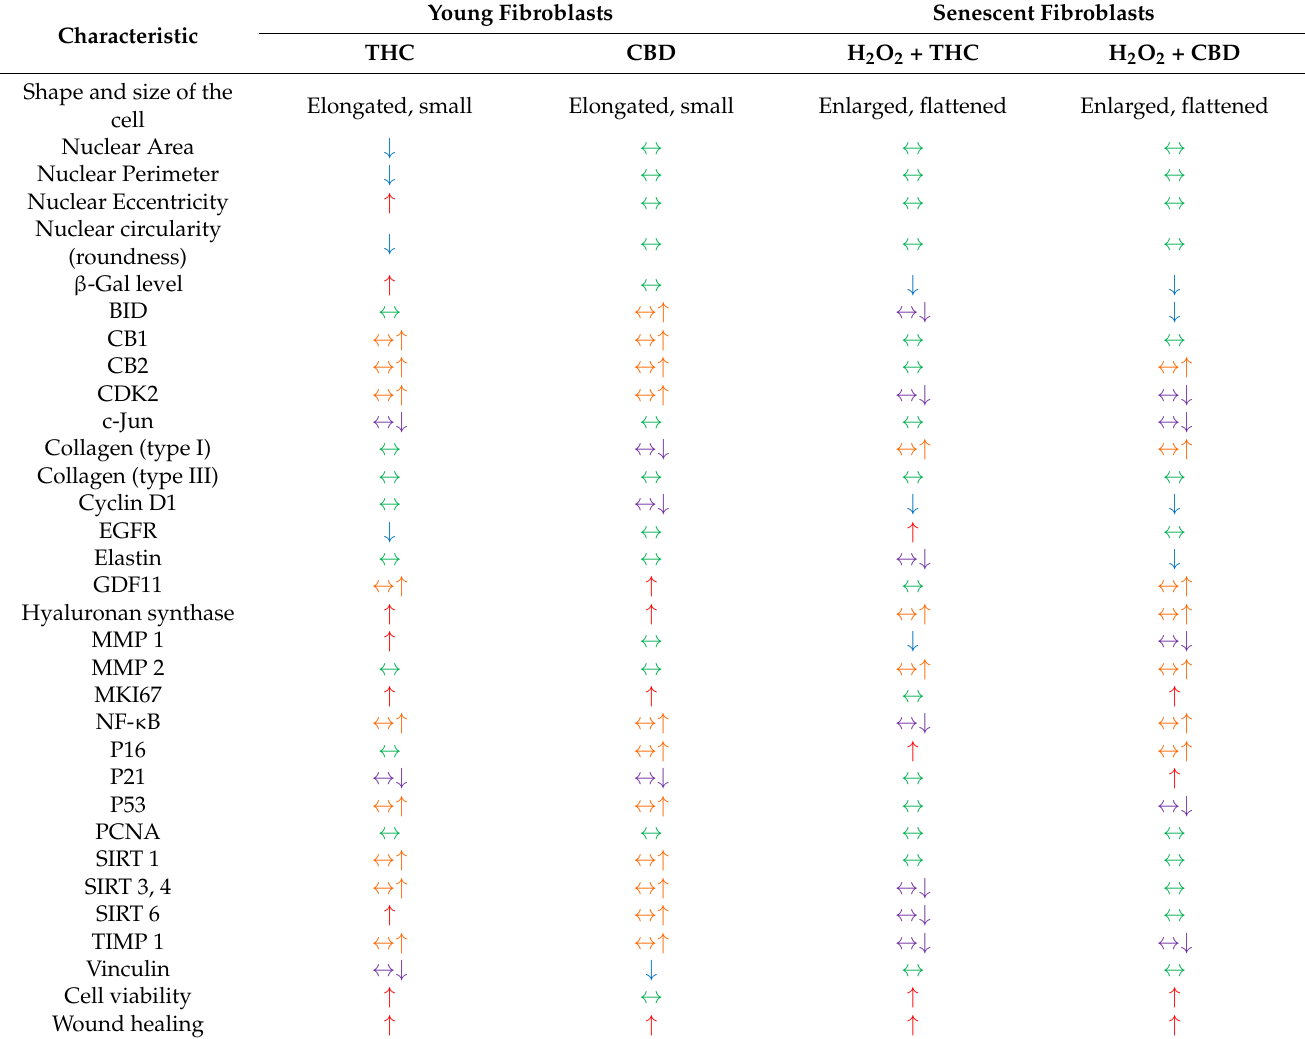
Table 1. Summary of the investigated characteristics of healthy and prematurely aged skin fibroblasts after phytocannabinoid